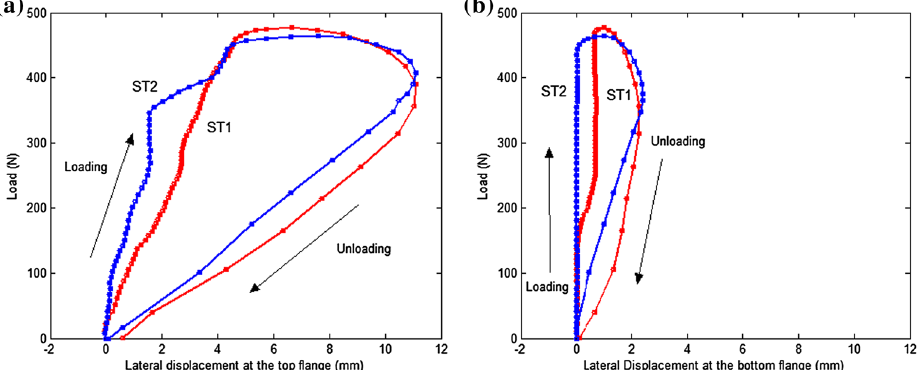
Fig. 10 Variations in the lateral displacements obtained from the horizontal potentiometers at the top and bottom flanges of the beam.